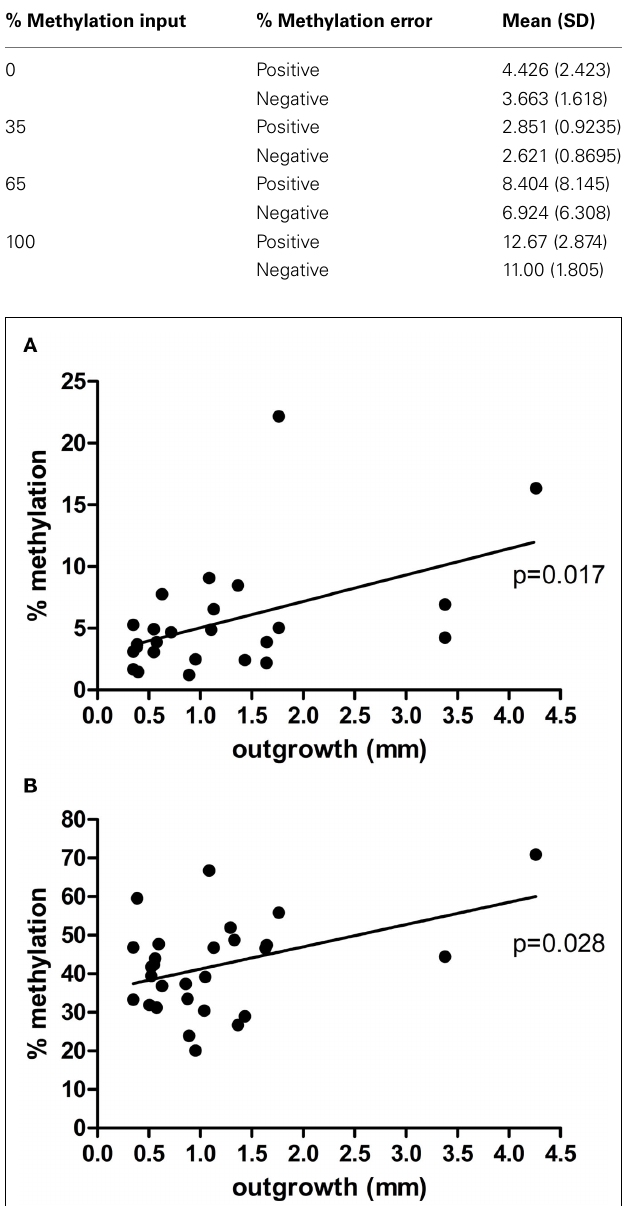
FIGURE 1 | Correlation between placental explant outgrowth and PRKCDBP (A) and MMP2 (B) promoter methylation in first trimester placenta.